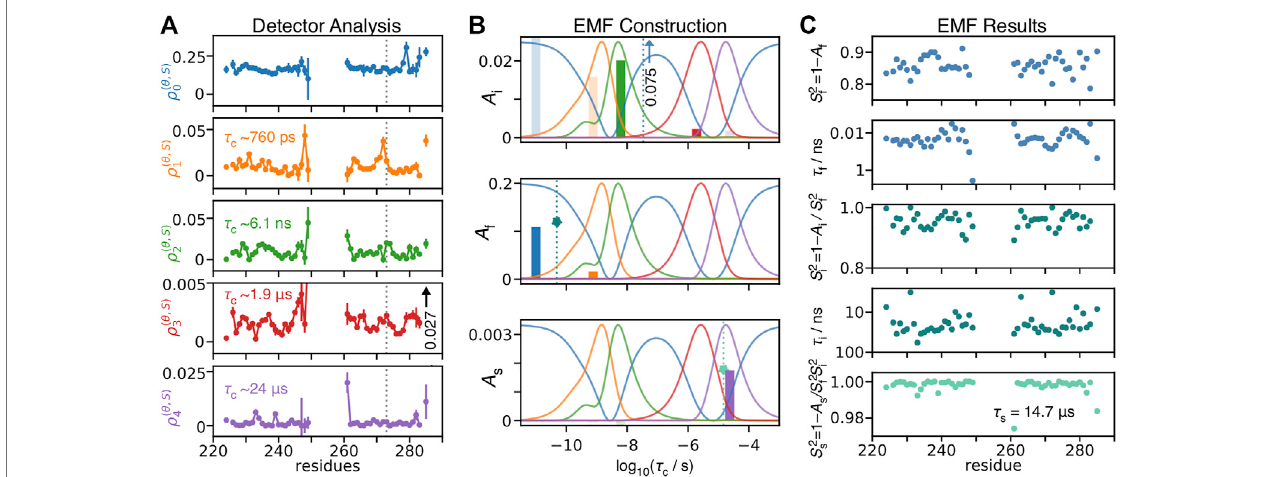
FIGURE11| Model-freeanalysisfromdetectors. (A) showsadetectoranalysisofHET-s(218 – 289) fi brils(Smithetal.,2016),withsensitivitiesshownin (B) (amplitudescale not shown; sensitivities have amaximum of1). (B) illustratesthe procedureto convert 273Ser detector responses intomodel-freeparameters. Bars give the detector responses ( y -axis), plotted at the center of the corresponding detector ’ s sensitivity ( x -axis, note that ρ 0 , blue, does not have a well-de fi ned center). At top, we fi nd the ratio of ρ ( θ , S ) 3 / ρ ( θ , S ) 2 is consistent with a correlation time of 34 ns, with corresponding amplitude of 0.075 (intermediate motion). After subtracting the contribution of this correlation time to ρ ( θ , S ) 0 (middle), we fi nd the ratio ρ ( θ , S ) 1 / ρ ( θ , S ) 0 is consistent with a correlation time of 49 ps, and amplitude of 0.12 (fast motion). Using a fi xed correlation time of 14.7 μ s, we fi nd an amplitude for the slow motion of 1.8 × 10 − 3 (bottom). (C) shows the results of EMF analysis for all residues using the procedure in (B)